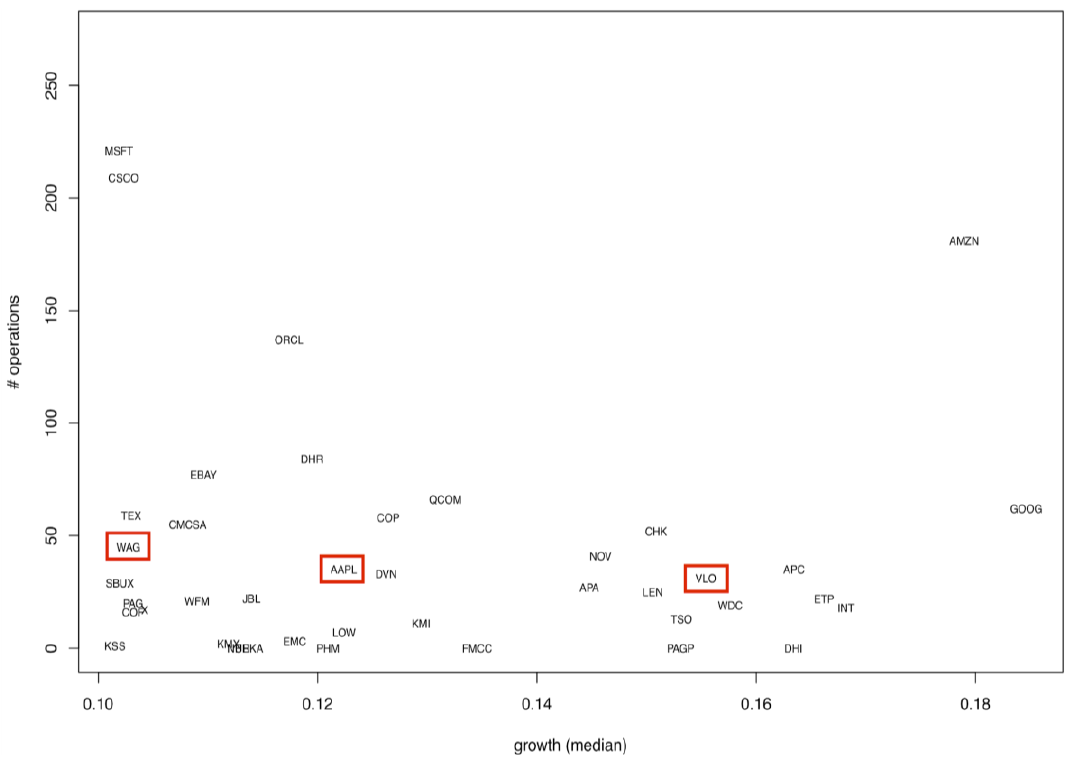
Figure 2: Firms by Annual Growth and Acquisitions (in frame, firms considered in qualitative